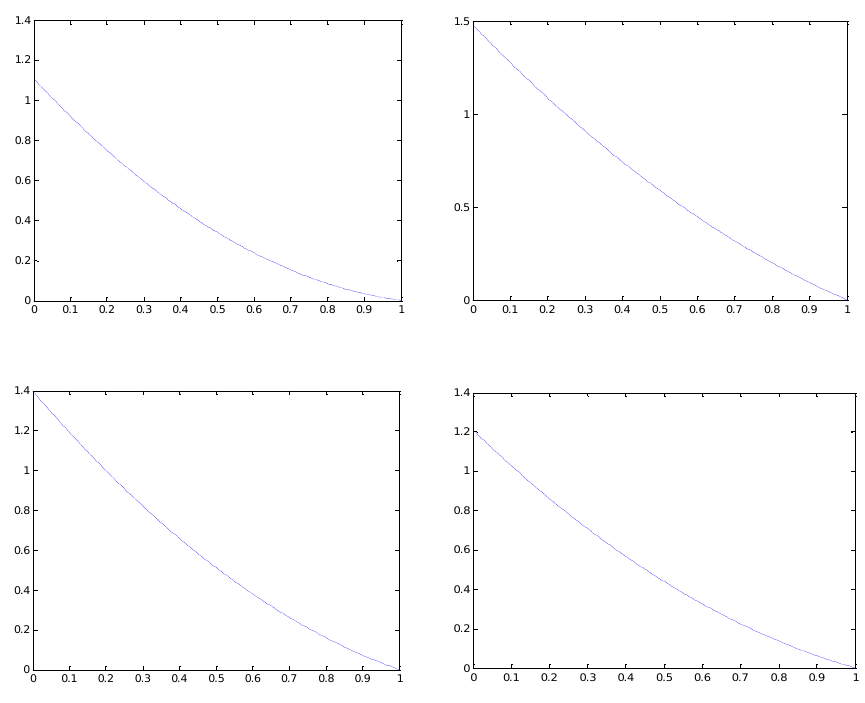
Figure 1. Experimental results for R( ρ ) curve.